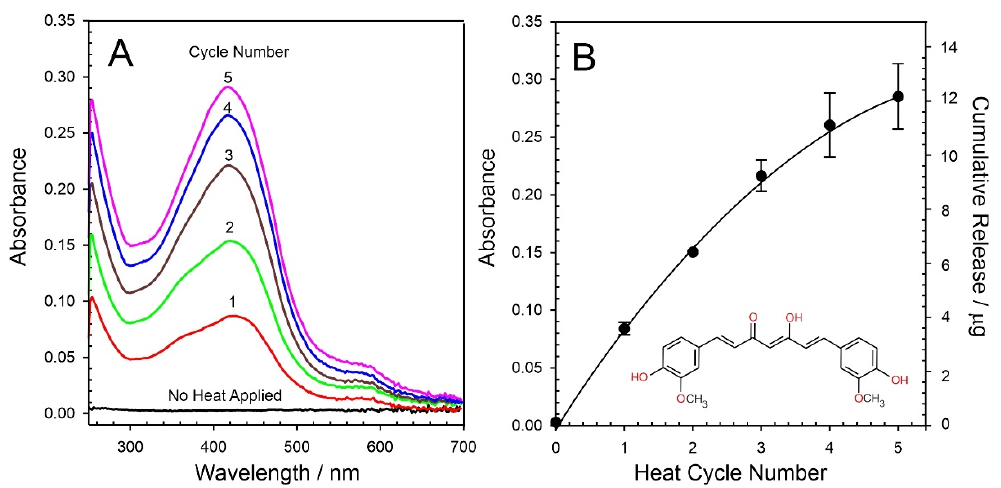
Figure 12. ( A ) UV/Vis spectra detailing the cumulative release of curcumin from a wax/AP-PEG polymer composite film directly into pH 6 buffer. ( B ) Estimation of the amount of curcumin released.